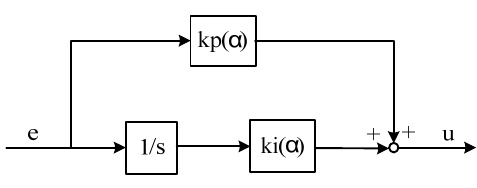
Figure 5. PI gain scheduled controller: case 2.